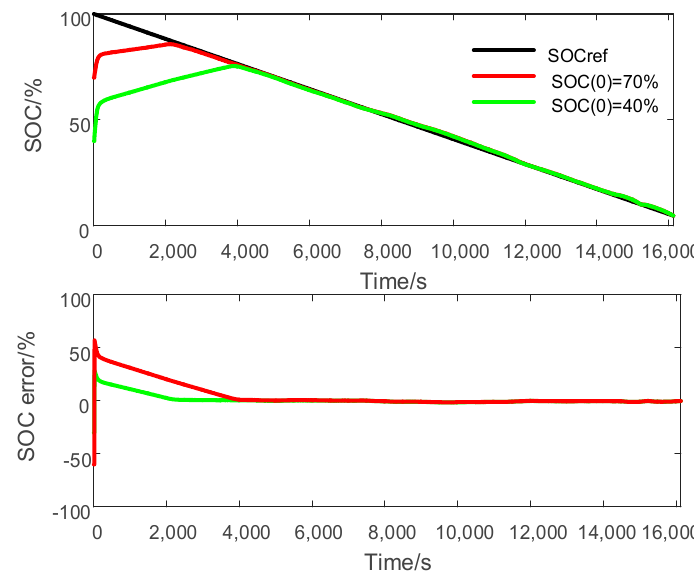
Figure 11. CSMO-based SOC estimation at different initial SOCs.